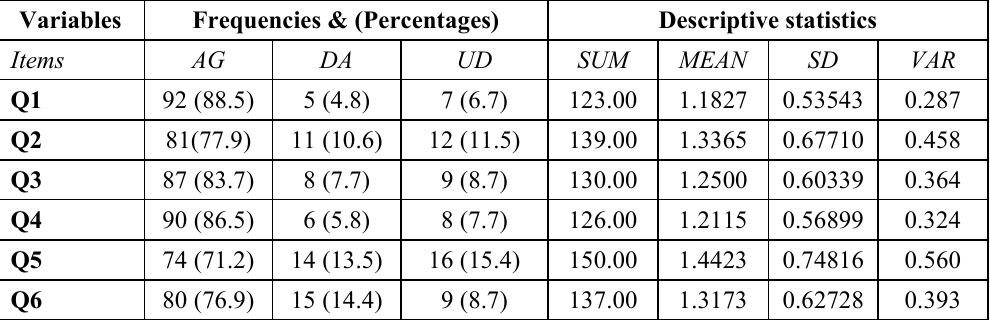
Table 3. Analysis of Data on Independent Variables (X) (made by the author) Variables Frequencies & (Percentages) Descriptive